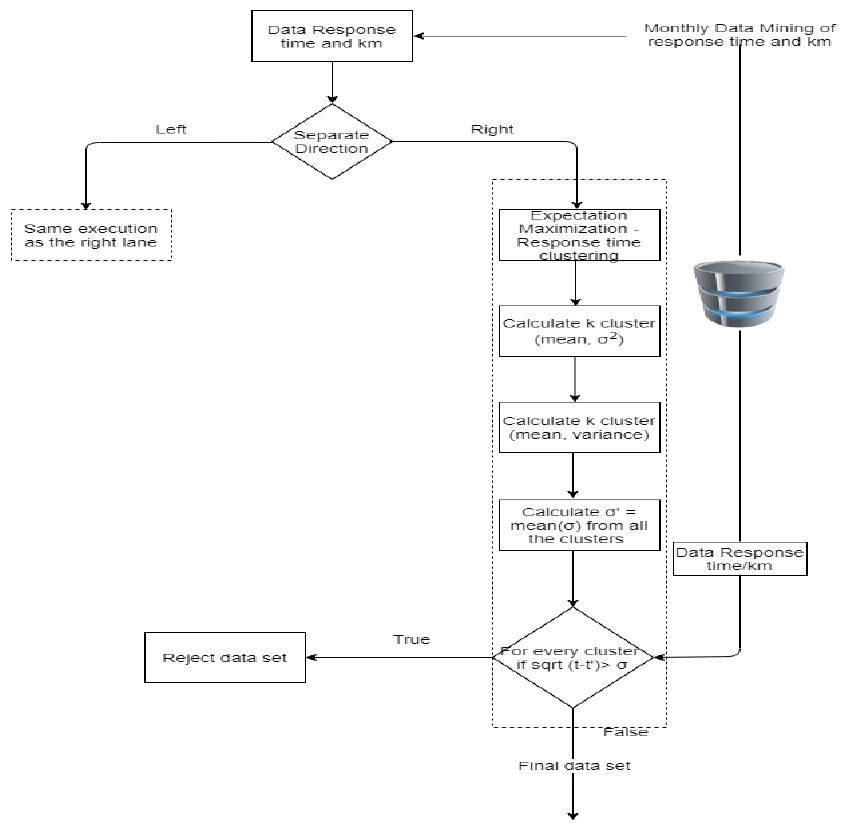
Figure 6. Flow chart of the response time algorithm data filtering and training.